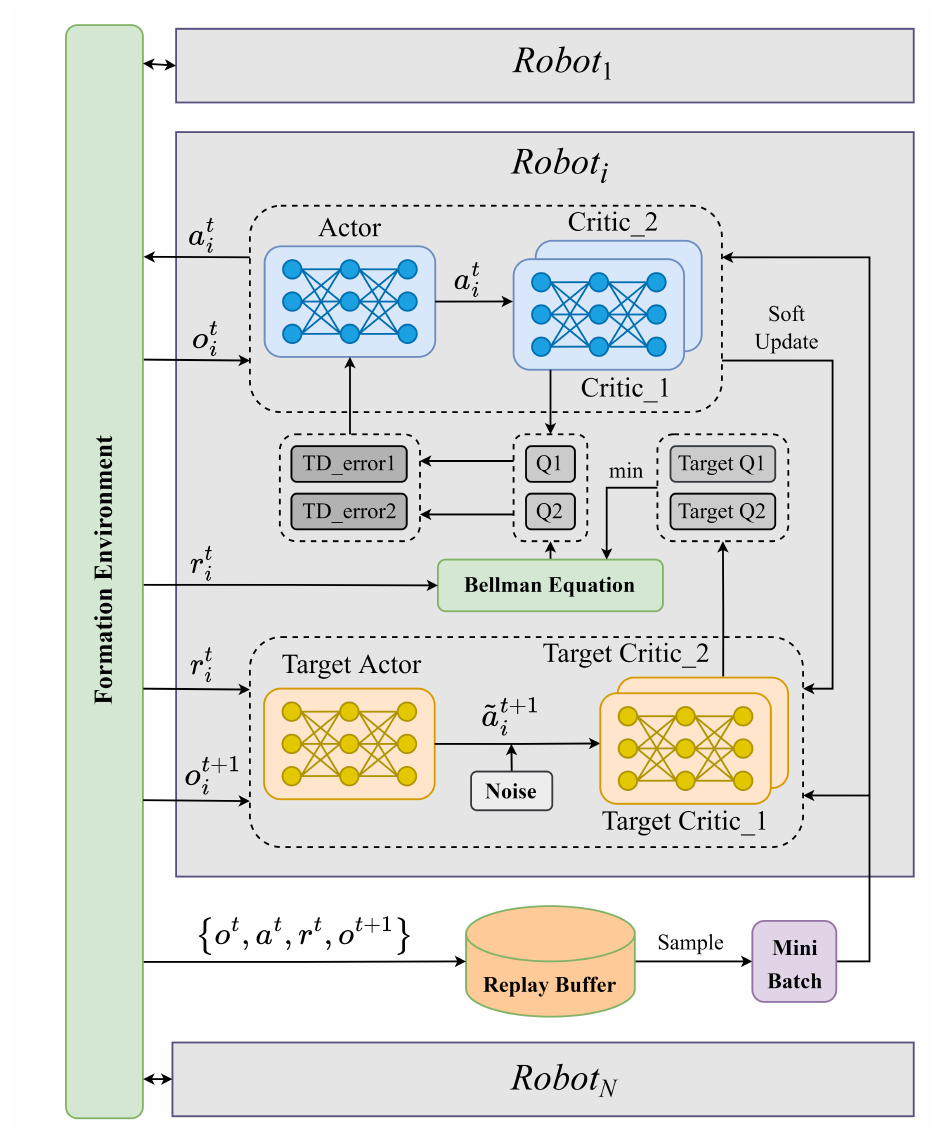
Figure 4. MATD3 algorithm